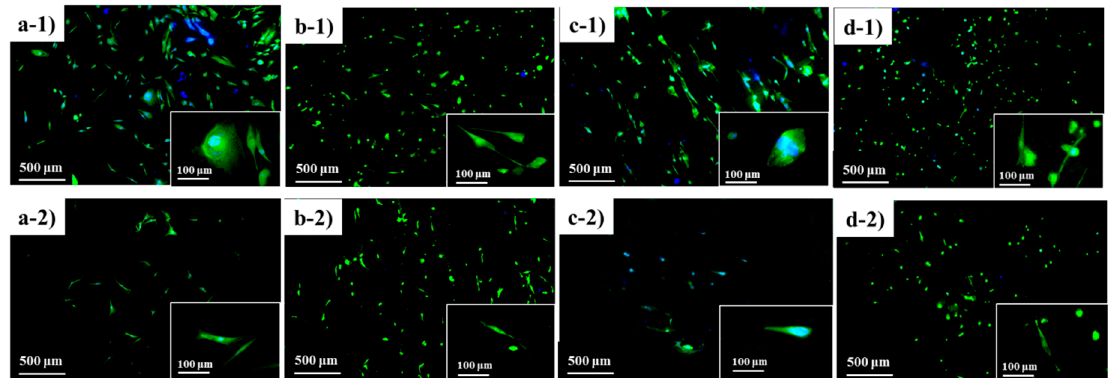
Figure 8. The biocompatibility of PCL-PDMS nanofiber mesh based on ( a ) viability percentage and ( b ) relative fold change relative to the control group.